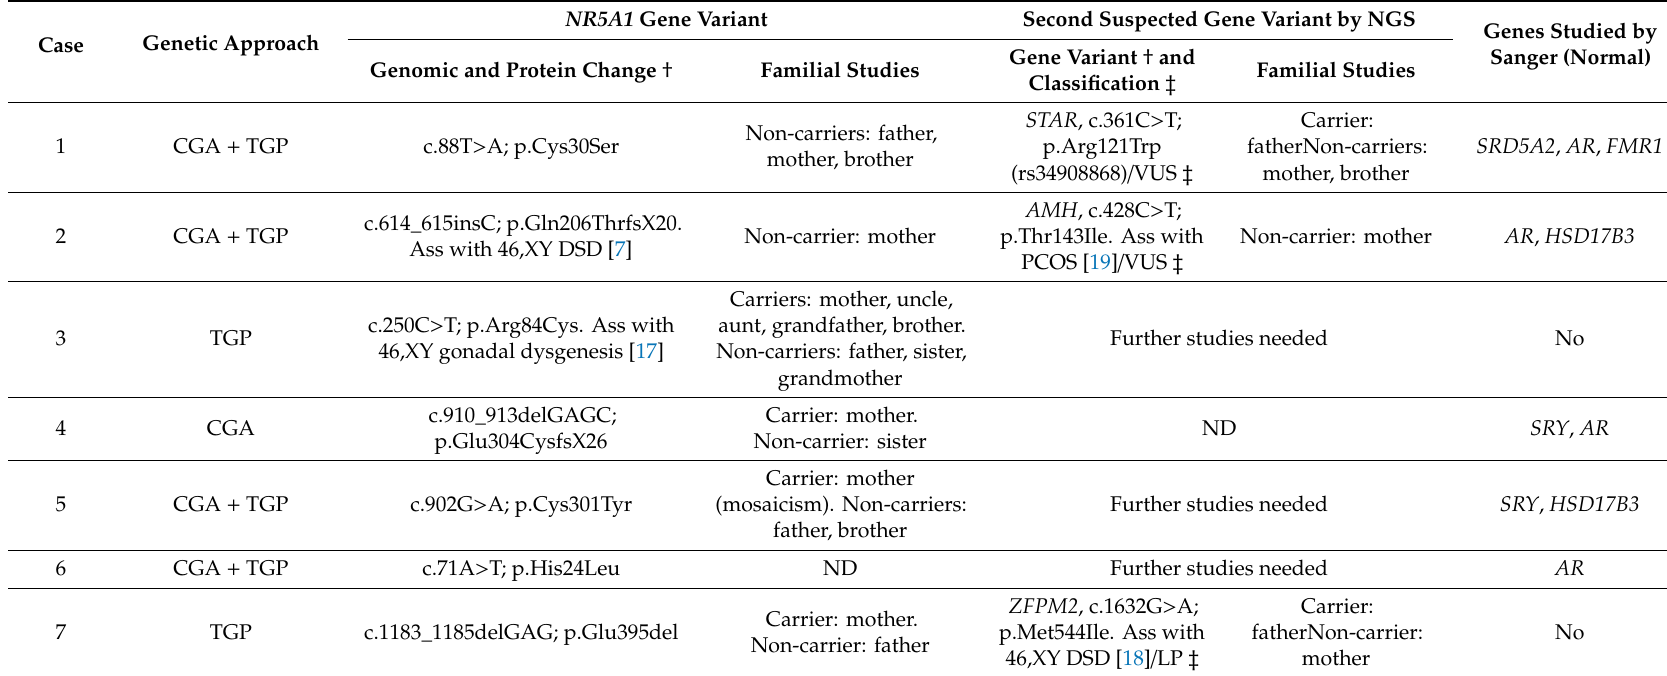
Table 2. Genetic findings of studied patients. Specific variants in NR5A1 and in other disorders of sex development (DSD)-related genes assessed by a DSD-tailored gene panel are listed